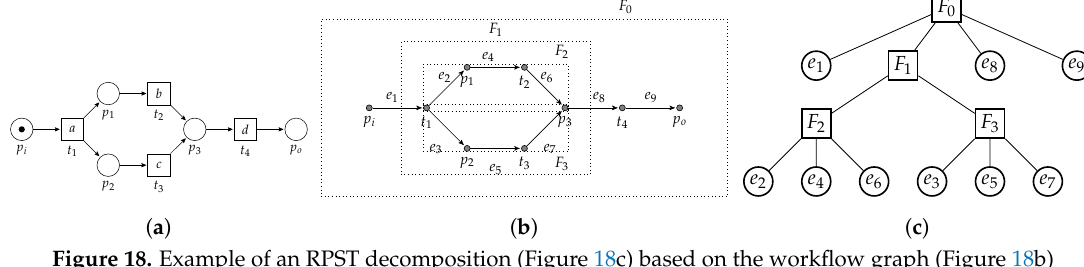
Figure 18. Example of an RPST decomposition (Figure 18c) based on the workflow graph (Figure 18b) of a simple sound WF-net W 2 (Figure 18a). ( a ) Simple unsound (not well-handled ) WF-net W 3 . ( b ) The workflow graph of W 3 , including its canonical fragments. ( c ) The RPST of W 3